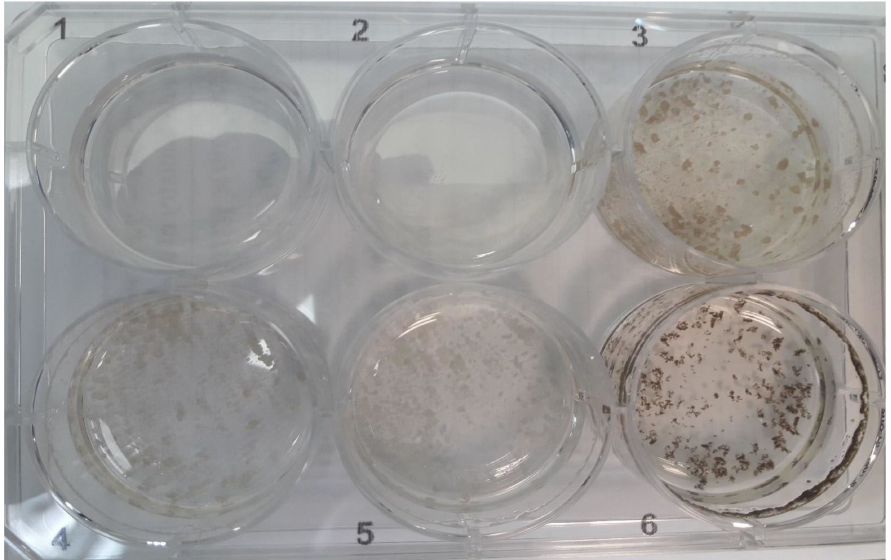
Figure 5. Inhibition P. sedebokerense growth in synthetic medium by increasing concentrations of glufosinate. Purified propagules (7 × 10 − 5 cells mL − 1 ) were inoculated in BGM medium with 2.5 (1), 1.25 (2), 0.5 (4), and 0.1 (5) mM glufosinate or without glufosinate (3, negative control); 6, coculture of P. sedebokerense and Haematococcus without glufosinate to show blastoclad infectivity. All cultures were incubated at 30 ◦ C for 3 days.